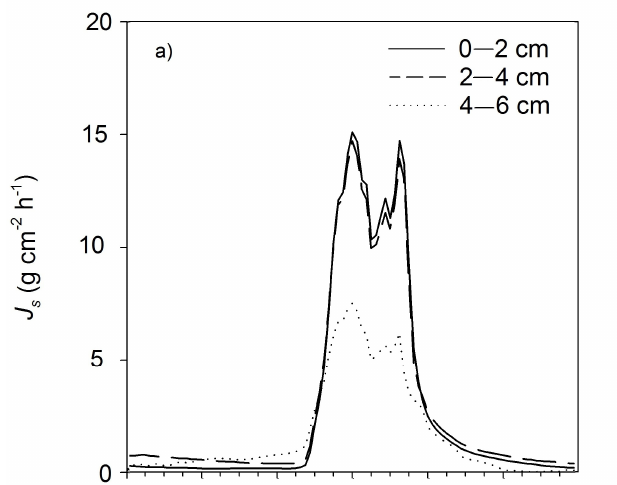
Figure 1. Diurnal courses of ( a ) photosynthetic photon flux density (PPFD), vapor pressure deficit (VPD), measured and modelled sap flux densities in a representative ( b ) Açaí palm and ( c ) Cupuaçu tree over five days in August 2011 (mean of n = 3, DOY = day of year, J s = Sap flux